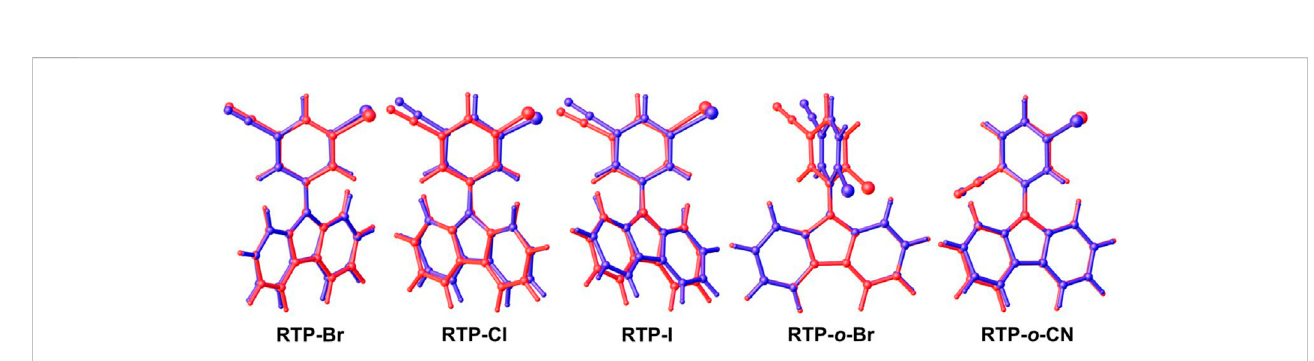
FIGURE 5 Superposition of X-ray crystal structure (blue) and theoretically calculated structure in S 0 geometry (red).